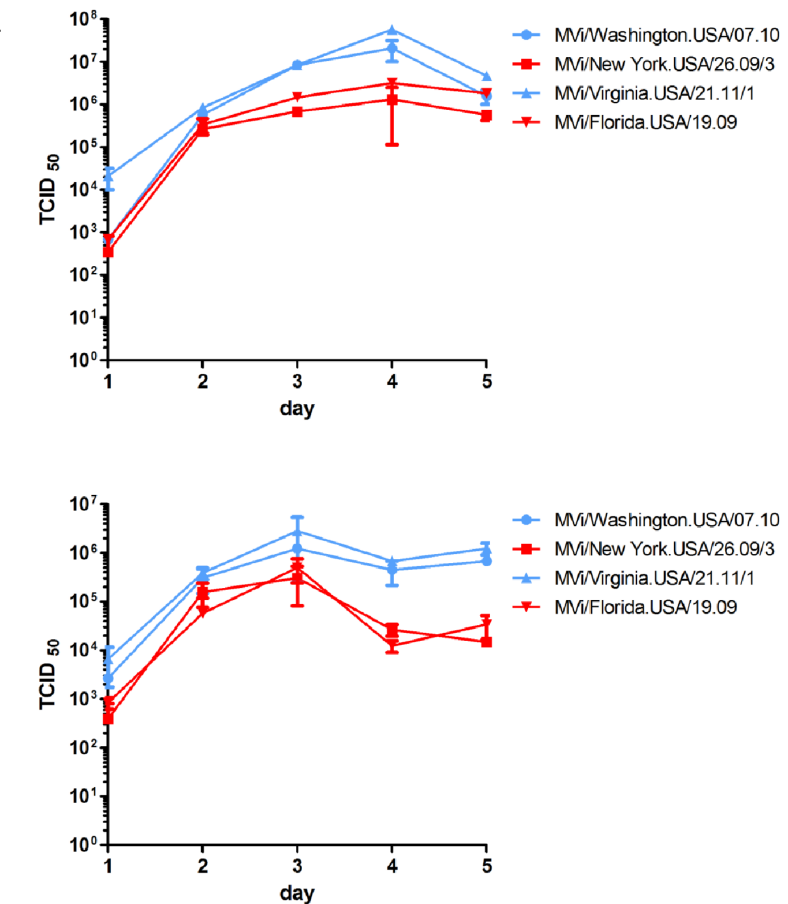
Figure 3. Multi-step growth curves of MeVs with and without the indels. MVi/New York.USA/26.09/3, MVi/Florida.USA/19.09, MVi/ Washington.USA/07.10 and MVi/Virginia.USA/21.11/1 were used to infect Vero/hSLAM cells (A) and A549/hSLAM cells (B) at an MOI of 0.001. At the indicated time points, cells were scraped into the medium and viral titer was measured by endpoint dilution on Vero-hSLAM cells. Titers represent averages of duplicate wells. Error bars depict one standard deviation. Blue symbols and lines indicate viral isolates without indels and red symbols and lines indicate viral isolates with indels.